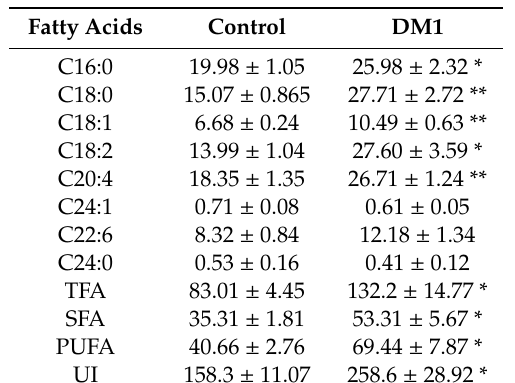
Figure 6. Fluidity of liver mitochondrial membranes of control and diabetic rats. The composition of the incubation medium was as indicated in Figure 5. Values are given means ± SEM ( n = 5). *** p < 0.001 compared to controls. Table 2. DM-related changes in the fatty acid composition of the mitochondrial membrane ( μ g per mg of mitochondrial protein).